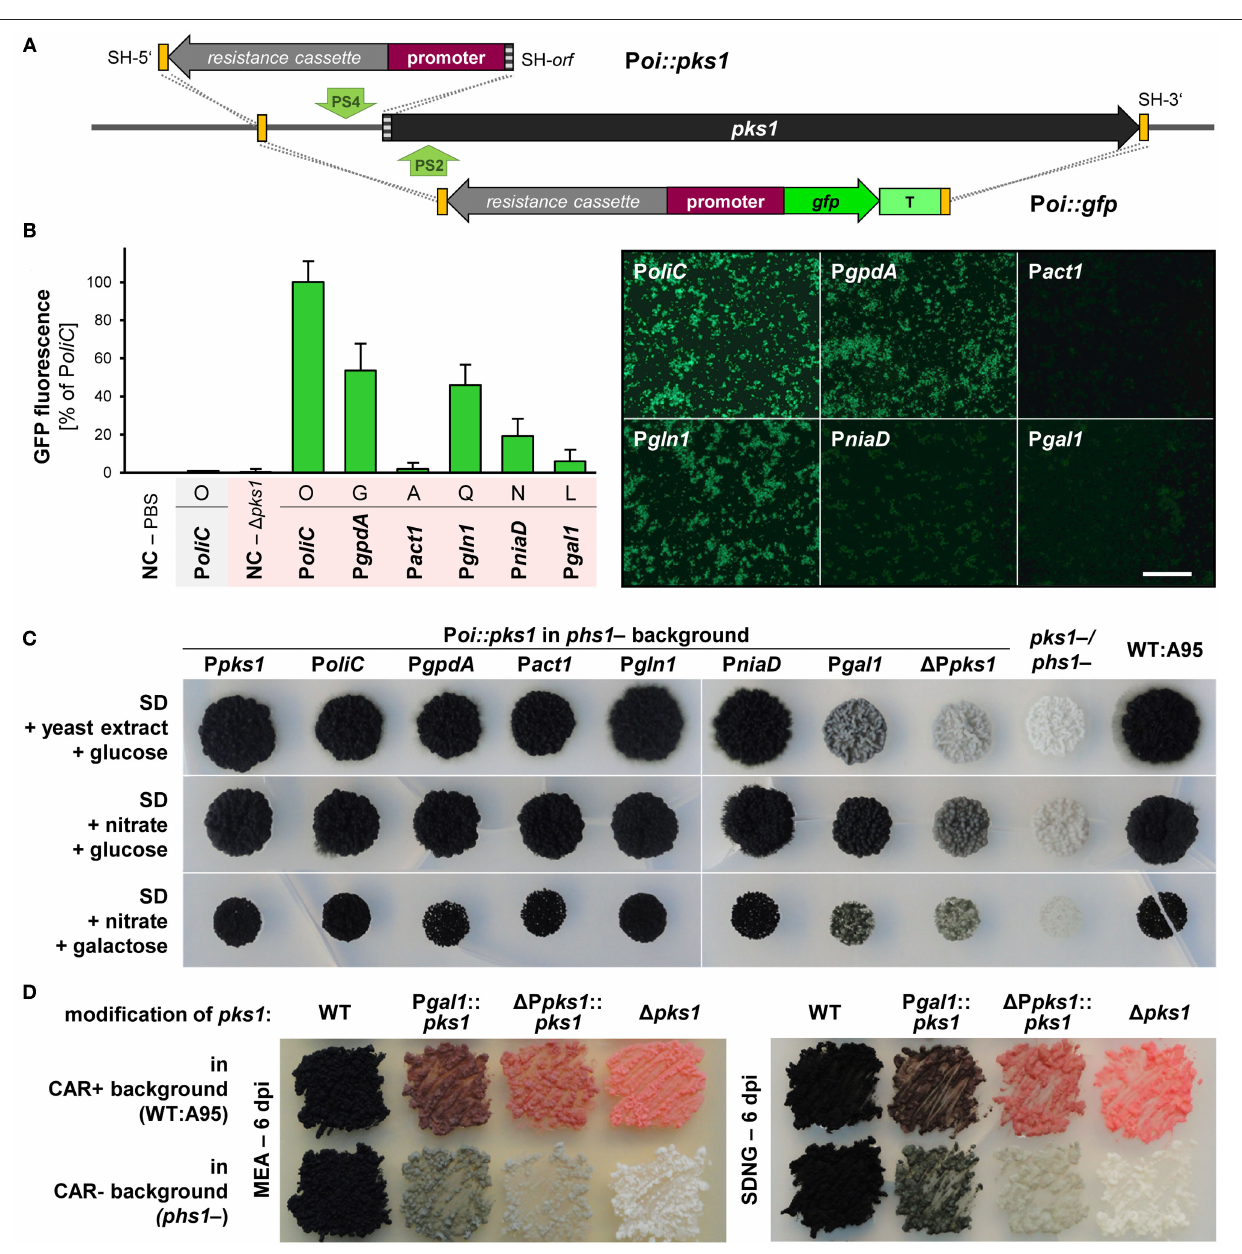
FIGURE 4 | Promoter studies using GFP/fluorescence and PKS1/pigmentation as reporters in K. petricola . (A) Strategies for the targeted integration of P oi::gfp and P oi -only constructs at the pks1 locus. The promoter and open reading frame of pks1 were replaced by constructs containing gfp under control of six different promoters (P oi ). This allowed for the isolation of correct (pink) strains (black-pink screening). For using pigmentation as reporter, the pks1 promoter (1-kb-long sequence upstream of ATG) was replaced by constructs containing the six different promoters. All constructs comprise a hygR cassette for selection. Constructs were amplified from different plasmids with primers containing SH sequences of the non-coding or coding regions of pks1 as 5 ′ overhangs (yellow/gray boxes). Green arrows highlight the Cas9 cutting sites (PS2, PS4). Primers and strategies for detection of HR events (dashed lines) are indicated in Supplementary Figures 9 , 10 . (B) Expression of gfp from P oliC and P gpdA but not from P act1 result in considerable GFP fluorescence. The pink P oi :: gfp strains were generated through co-transformation of WT:A95 protoplasts with pAMA/ribo- pks1 PS2 and the six different P oi :: gfp constructs with homologous sequences to the 5 ′ - and 3 ′ -noncoding of pks1 ( Supplementary Table 4 ; Supplementary Figure 9 ). Three strains per construct were cultivated for 7 days in liquid culture. GFP fluorescence was quantified by a microplate spectrophotometer (10 9 cells per well). Mean values and standard deviations were calculated from three strains per construct and three wells per strain; except for P oliC::gfp in WT background (shaded gray; no standard deviation given as duplicates only). Negative controls (NC) were PBS only and cells of the GFP-free pink strain 1 pks1 (left). Fluorescence patterns of the same cell suspensions observed by fluorescence microscopy with exposure times of 400ms (right). Scale bar − 300 µ m. (C) Almost all promoters efficiently drive pks1 expression resulting in pigmented colonies. Strains in which pks1 is controlled by the P oi were generated by co-transformation of carotenoid-deficient phs1- protoplasts with pAMA/ribo- pks1 PS4 and the six different hygR-promoter constructs or with hygR